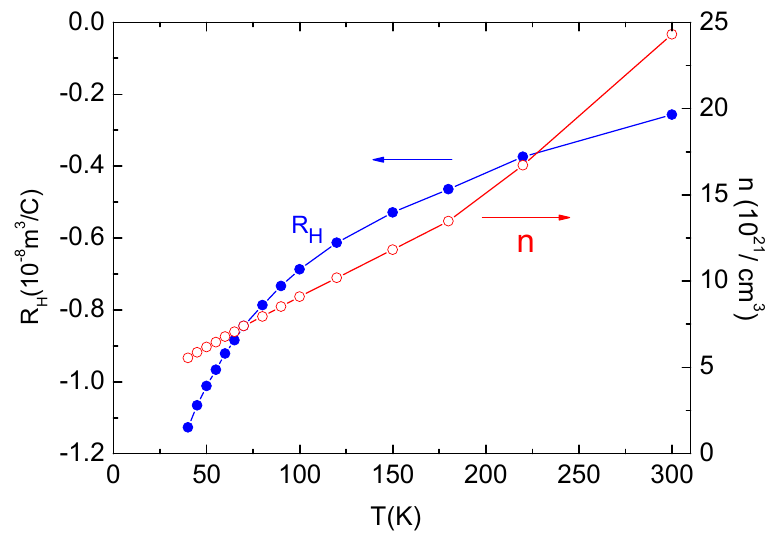
Figure 9. Hall coefficients R H ( T ) (blue dots) and carrier concentration (red circles) between 40 K and 300 K for Ca 10 (Pt 4 As 8 )((Fe 0.86 Pt 0.14 ) 2 As 2 ) 5 . The solid lines are guides for the eye.